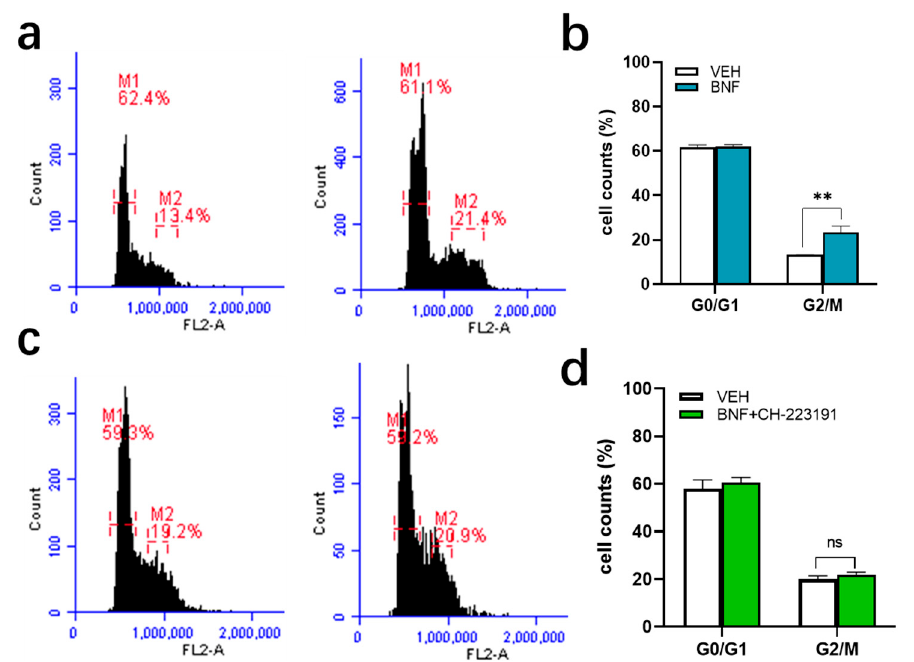
Figure 3. AhR activation in IEC-6 cells results in G2 / M cell cycle arrest as determined by flow cytometry. ( a , b ) cells treated with BNF for 24 h or vehicle; ( c , d ) cells pretreated with AhR inhibitor CH-223191 (10 μ M) and exposed to BNF or vehicle for 24 h. Results are expressed as Mean ± SD and analyzed by one-way ANOVA (Significance: ** p < 0.01). The term “ns” is defined as not significant.